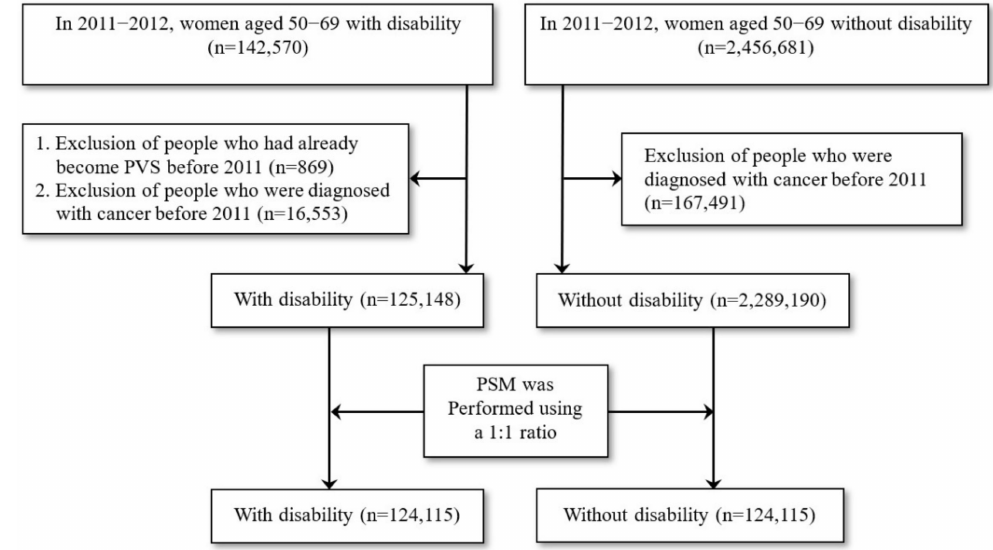
Figure 1. Study participants were selected and matched between women with and without